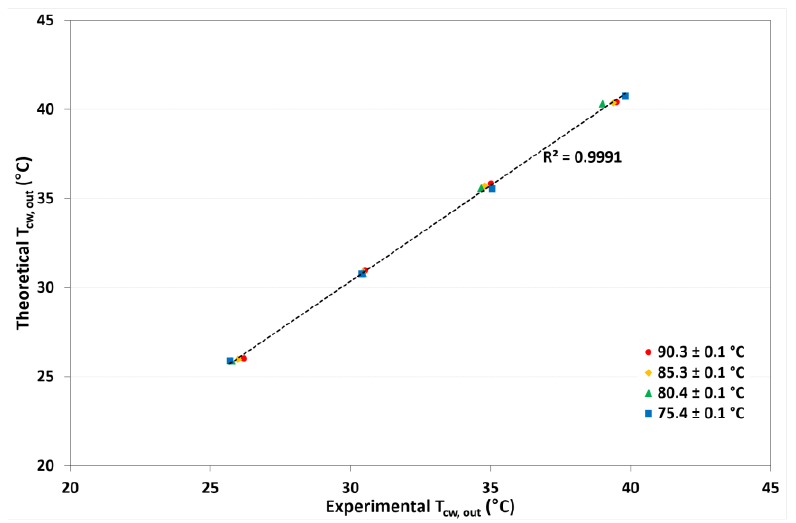
Figure 11. Comparison between theoretical and experimental outlet cooling temperatures.